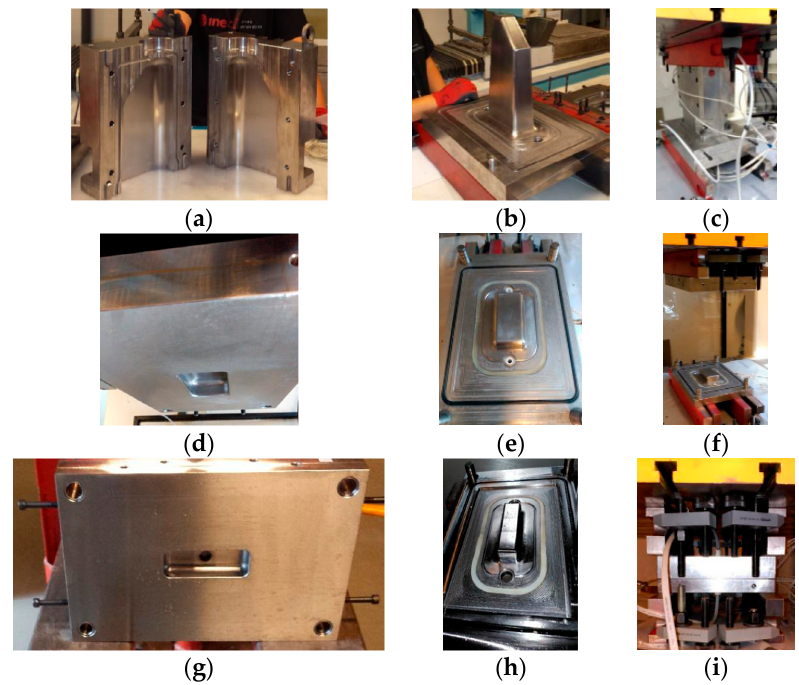
Figure 19. Manufactured moulds ( a ) breadboard female ( b ) breadboard male ( c ) breadboard assembly ( d ) lid female ( e ) lid male ( f ) lid assembly ( g ) feet female ( h ) feet male ( i ) feet assembly.